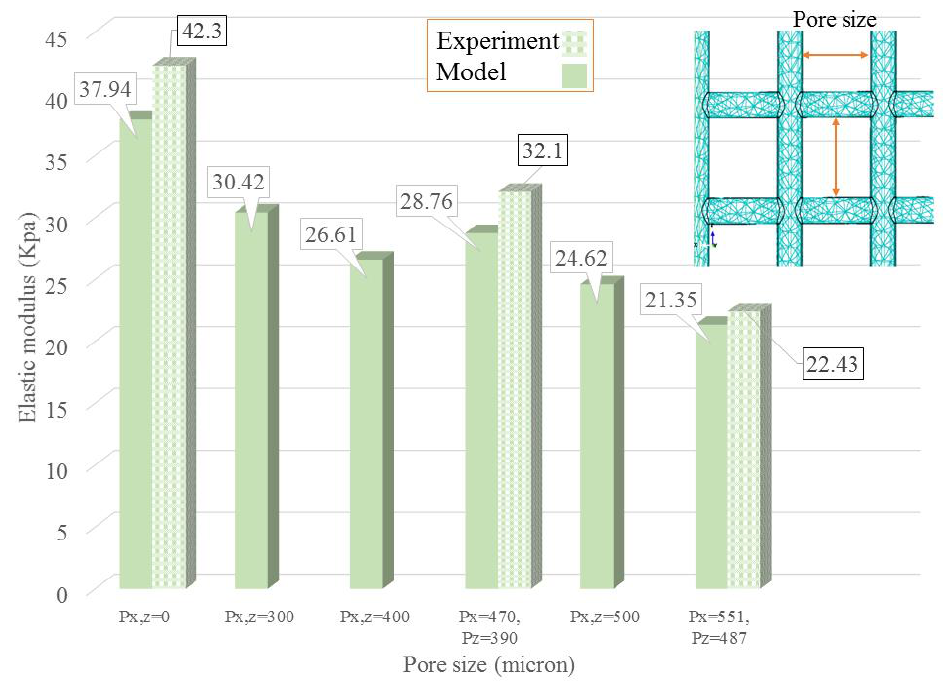
Figure 6. Effect of pore size on the elastic modulus (pattern fill column bars show experimental results for bioplotted scaffolds with ( P x , z = 0), ( P x = 470 and P z = 390), and ( P x = 551 and P z = 487)).